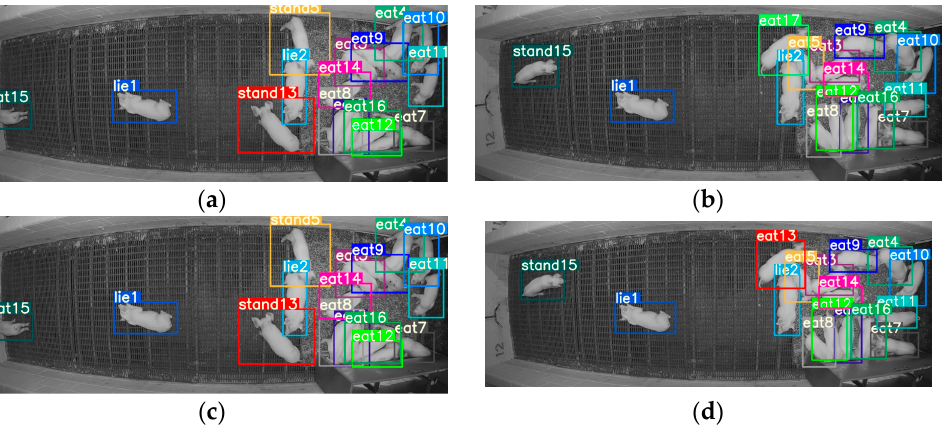
Figure 9. Tracking results of original and improved DeepSORT based on YOLOX-S model of Pig15. ( a ) Frame 50, original DeepSORT; ( b ) Frame 150, original DeepSORT; ( c ) Frame 50, improved Deep- SORT; and ( d ) Frame 150, improved